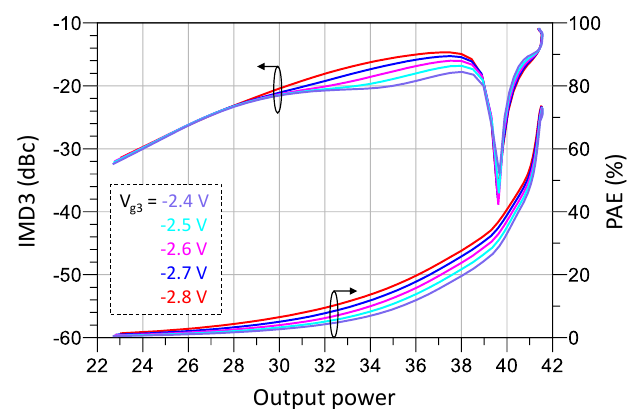
Figure 11. LS investigation with V g2 variation.